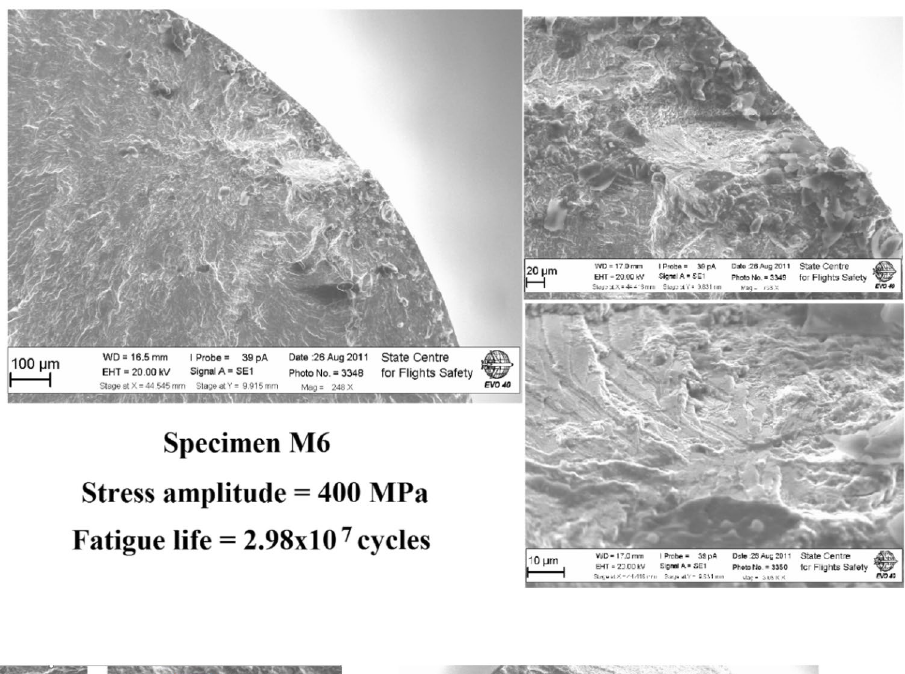
Fig. 7 Fracture of titanium alloy VT3-1 in VHCF region as a result of quasi-brittle fracture of alpha plate agglomeration